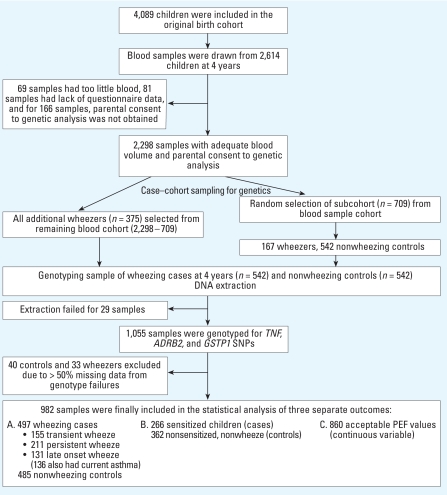
The BAMSE study design: selection of subjects for genotyping and exclusion of subjects following the genotyping procedure.